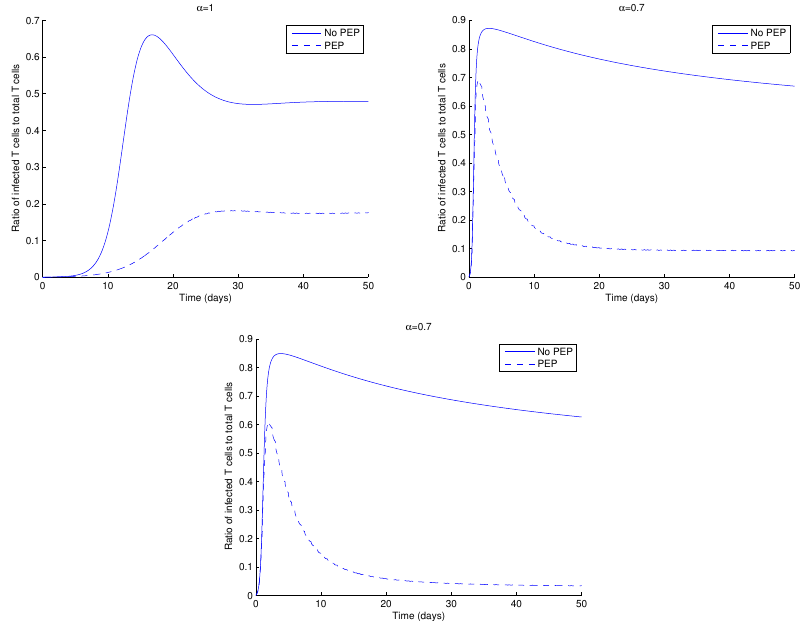
Figure 6. Ratio of infected CD4 + T cells, I + I R , to total CD4 + T cells, T + L + I + T R + I R of system (1) for α = 1 ( top left ), α = 0.9 ( top right ) and α = 0.7 ( bottom ). Parameter values and initial conditions in the text, except R k =